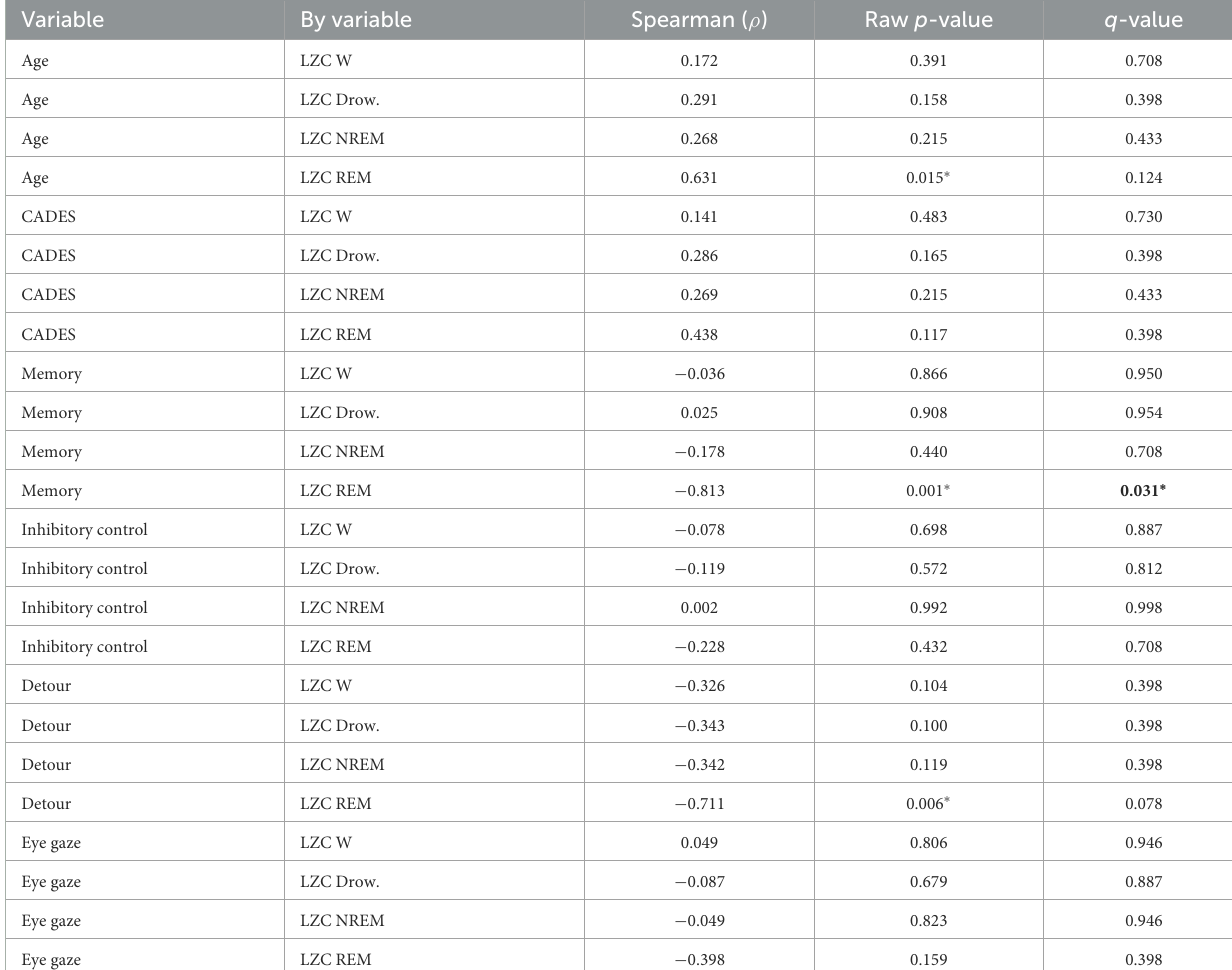
TABLE 2 Correlation between Lempel Ziv Complexity at Fz and age and cognitive function.